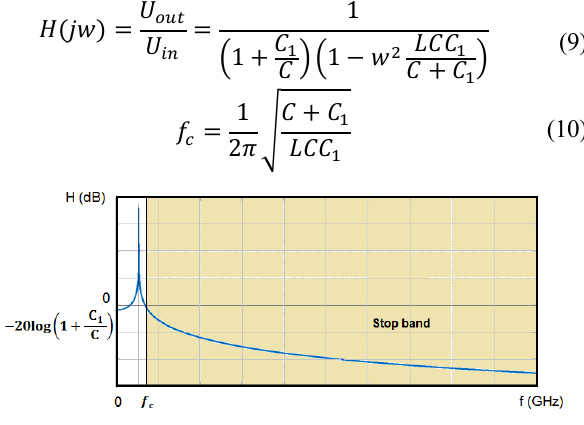
FIGURE 9. The magnitude of the frequency response of the proposed decoupling structure